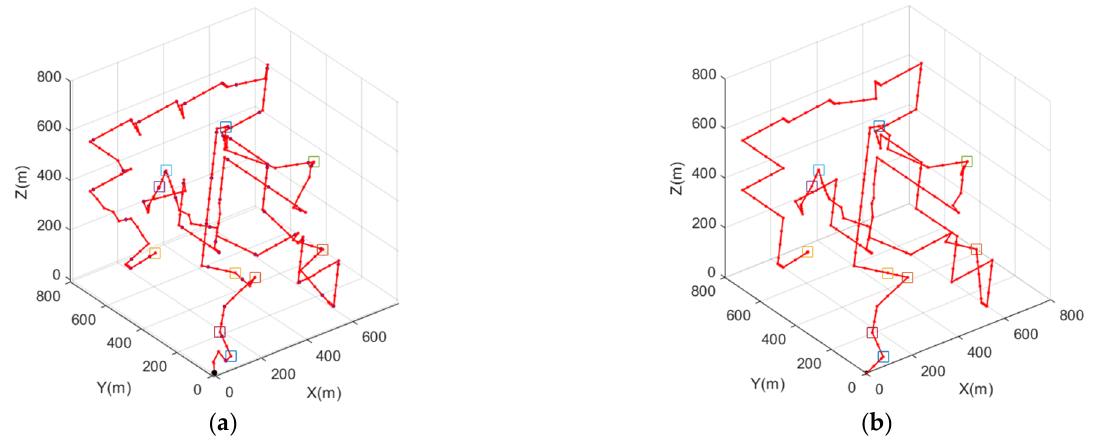
Figure 16. The comparison of the search paths generated by the two algorithms: ( a ) search path generated by the conventional RRT algorithm and ( b ) search path generated by the improved RRT algorithm.